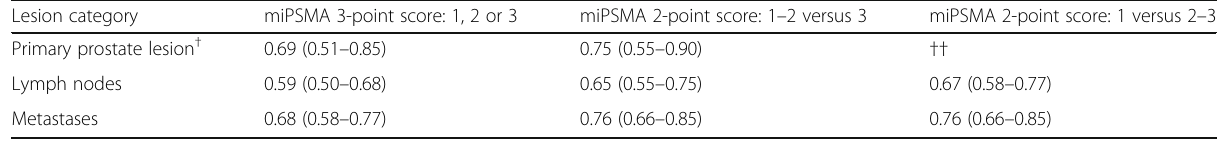
Table 3 miPSMA score observers ’ agreement K ’ s alpha (95% confidence interval)